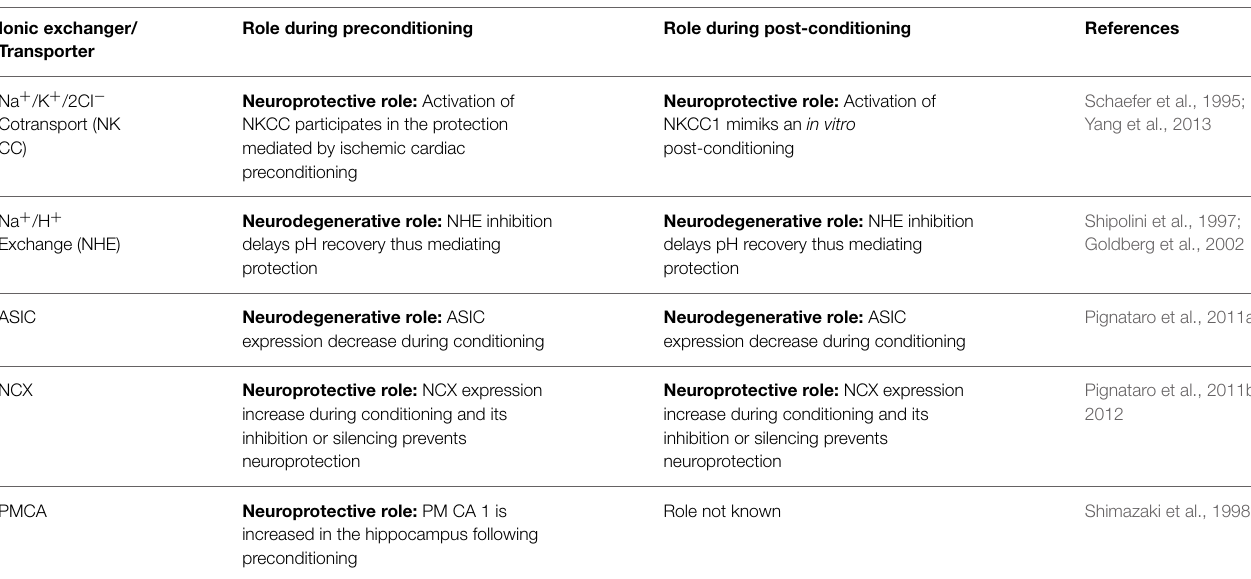
TABLE 1 | Role of ionic exchangers/transporters during pre-and